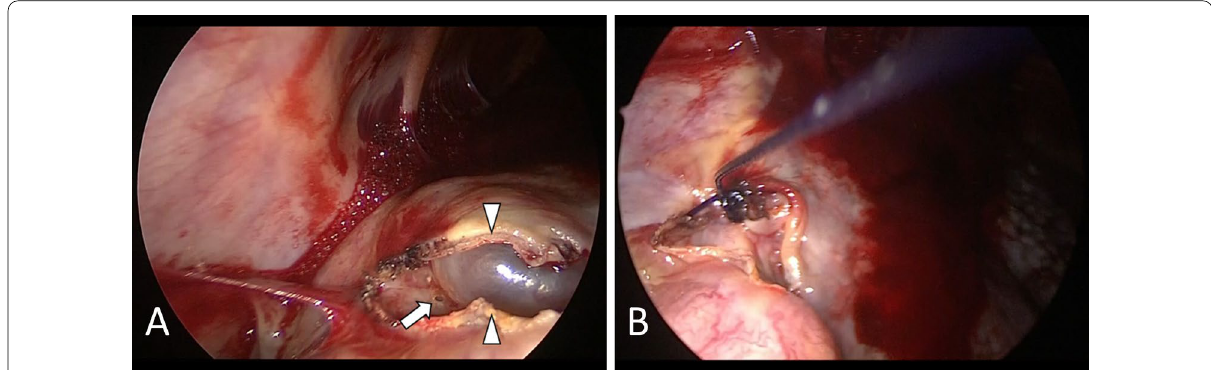
Fig. 3 Thoracoscopic images. A Image showing a small pore on a cyst in the lower lobe (arrow). Arrowheads indicate edges of the dissected adhesive tissue. B Image taken after closure of the air-leak